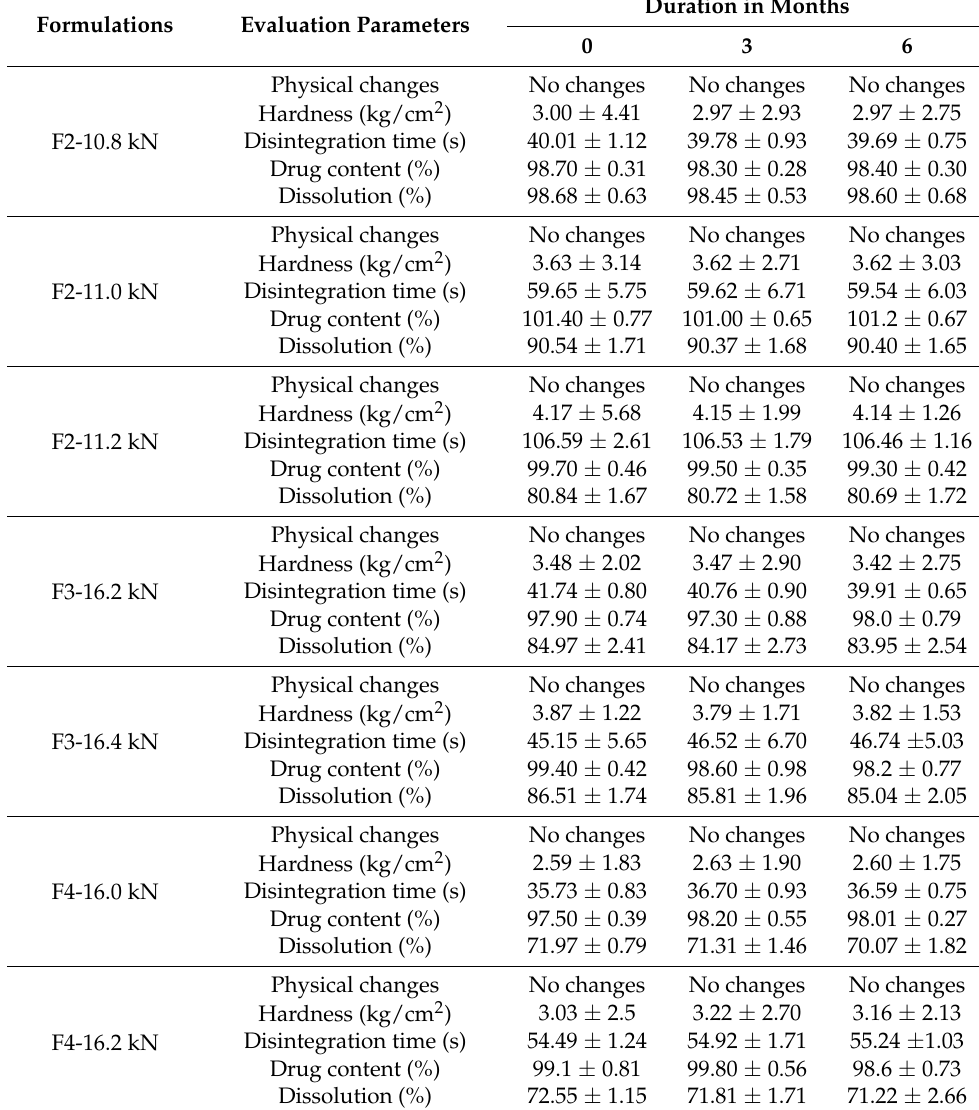
Table 6. Stability data of F2 formulation (compression force 10.8 kN; 11.0 kN; 11.2 kN) F3